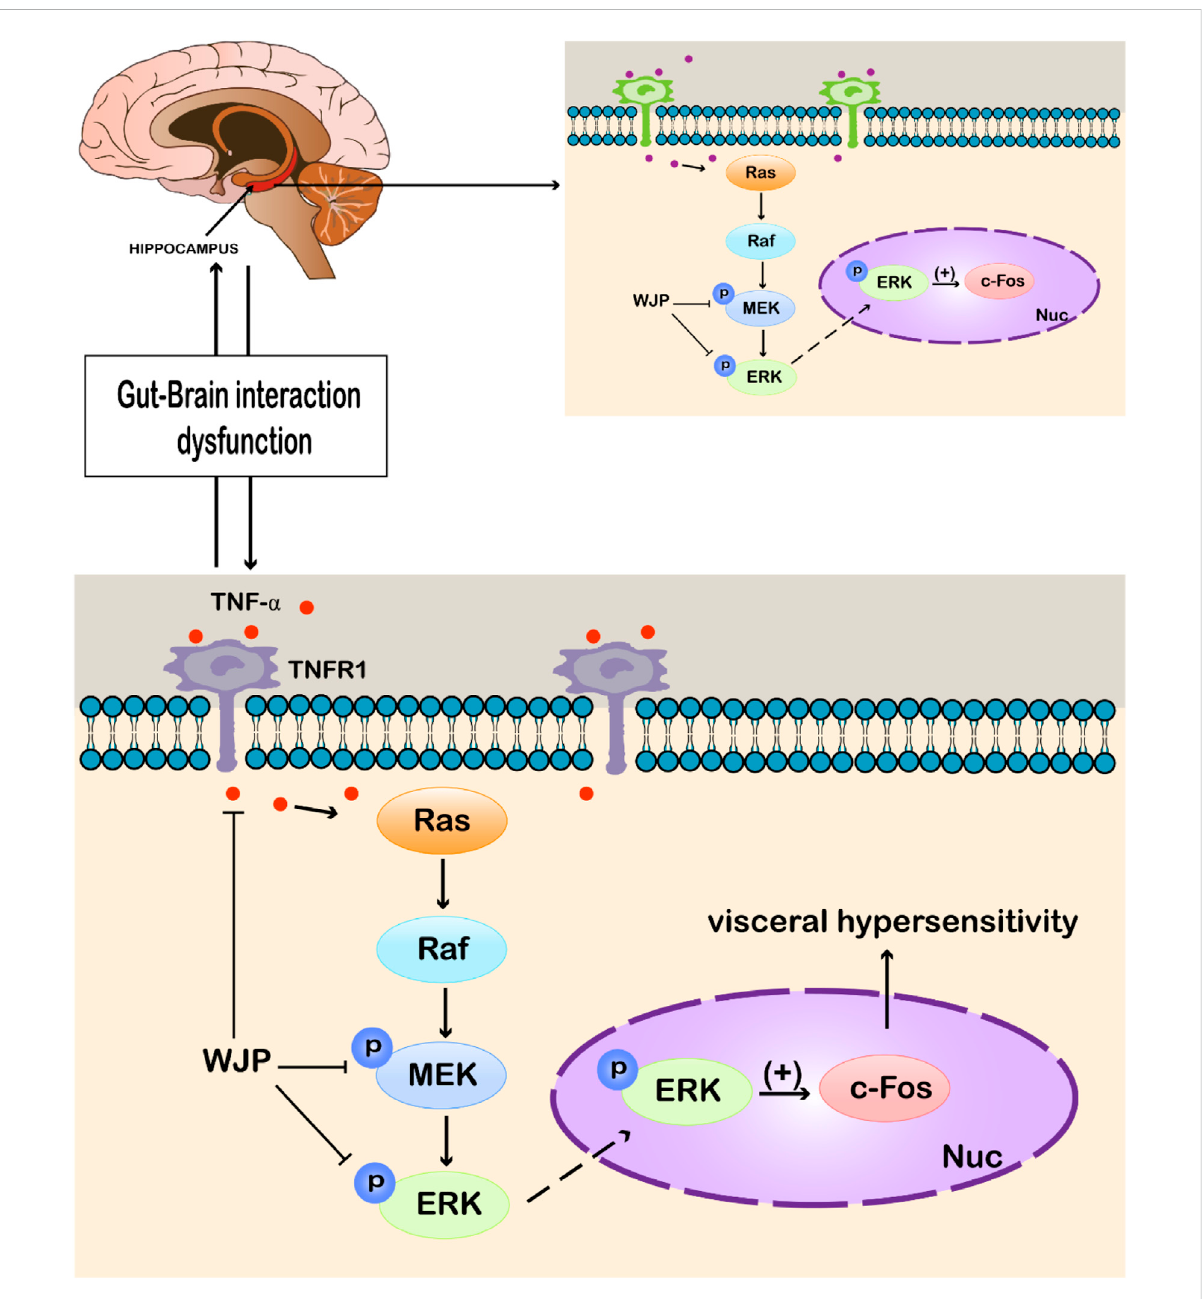
FIGURE 10 WJP regulation of the MEK/ERK signal pathway. Abbreviations: WJP, Wenshen-Jianpi Prescription; TNF- α , tumor necrosis factor- α ; TNFR1, tumor necrosis factor receptor-1; MEK, mitogen-activated extracellular signal – regulated kinase; ERK, extracellular regulated protein kinases; p, phosphorylation; Nuc, cell nucleus; (+), activating the